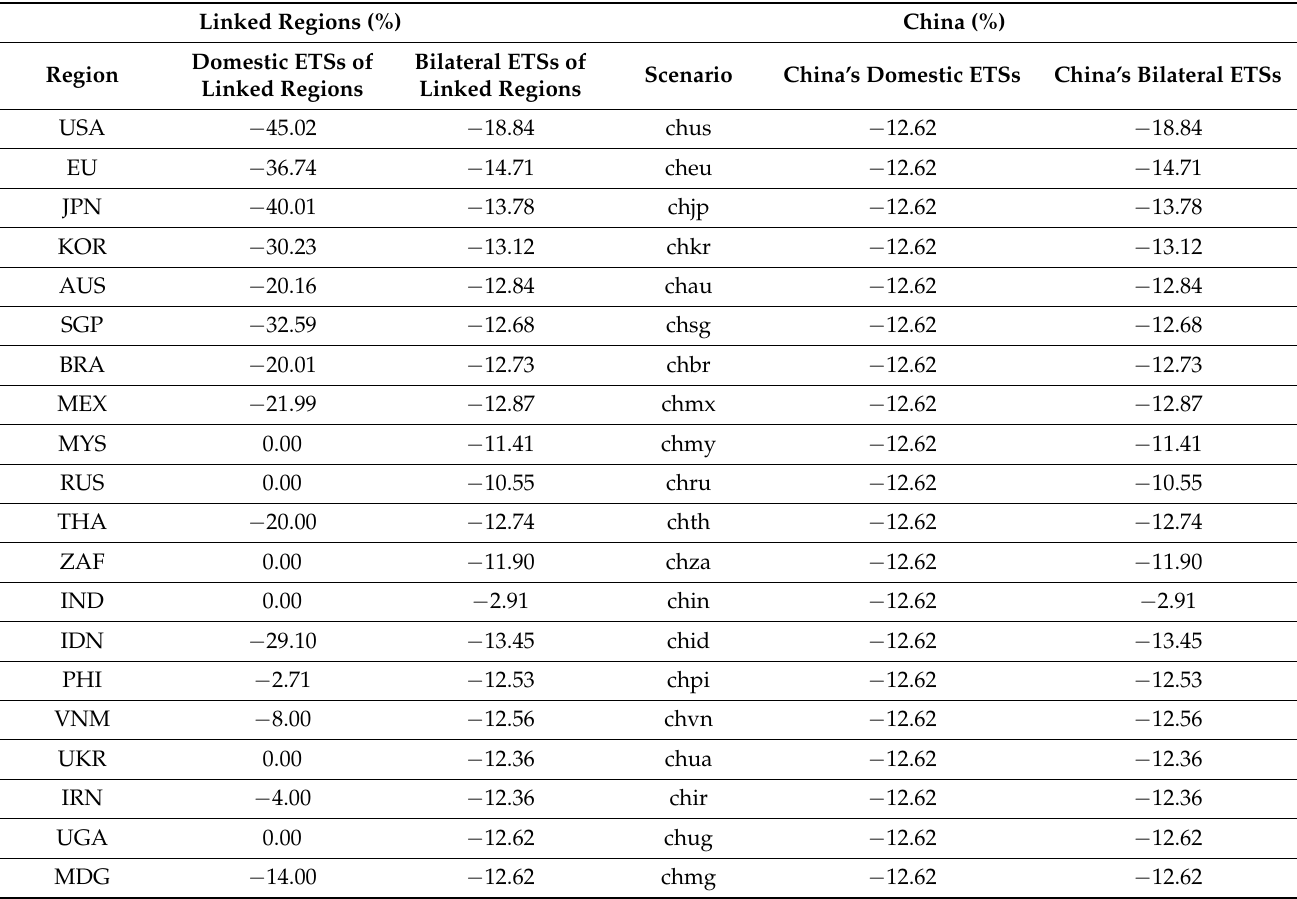
Table 5. Decarbonisation effects of emissions trading systems in various